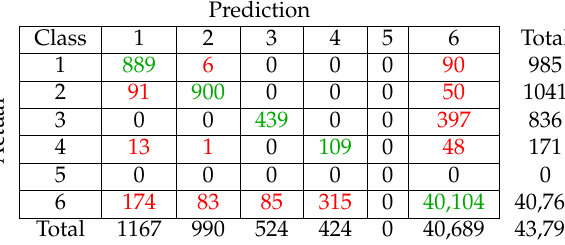
Table 4. Confusion matrix displaying results from the logistic regression classifier. The green highlighted numbers are true positives, and the red highlighted numbers are false